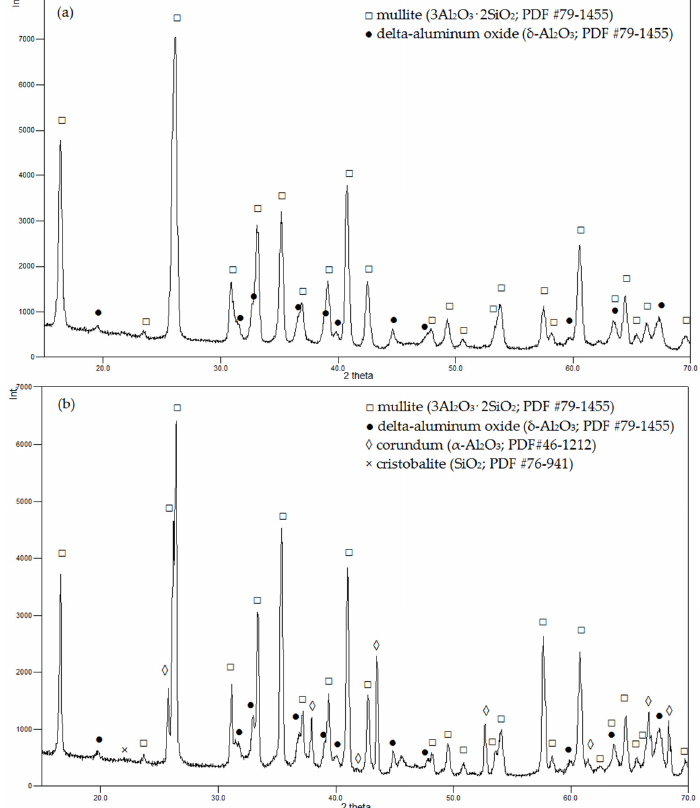
Figure 7. The diffraction pattern of the specimens of the material III after exposure to concentrated solar radiation: the specimen from the “cold” side of the sample treated in the first mode ( a ); the specimen from the “hot” side of the sample treated in the first mode ( b ).